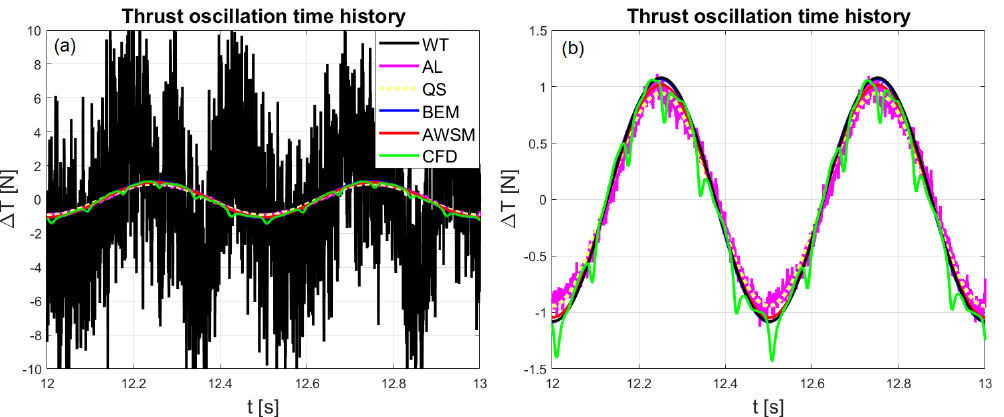
Figure 8. Thrust oscillation time histories for case 59 (a) , same plot considering only the surge harmonic of wind tunnel measurements (b) .